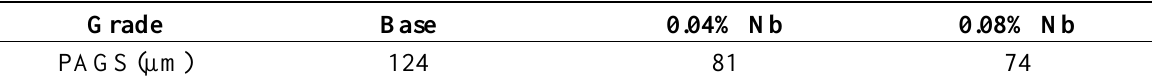
Table 3. Prior austenite grain size (PAGS), for base, 0.04% Nb and 0.08% Nb CASTRIP Steel.